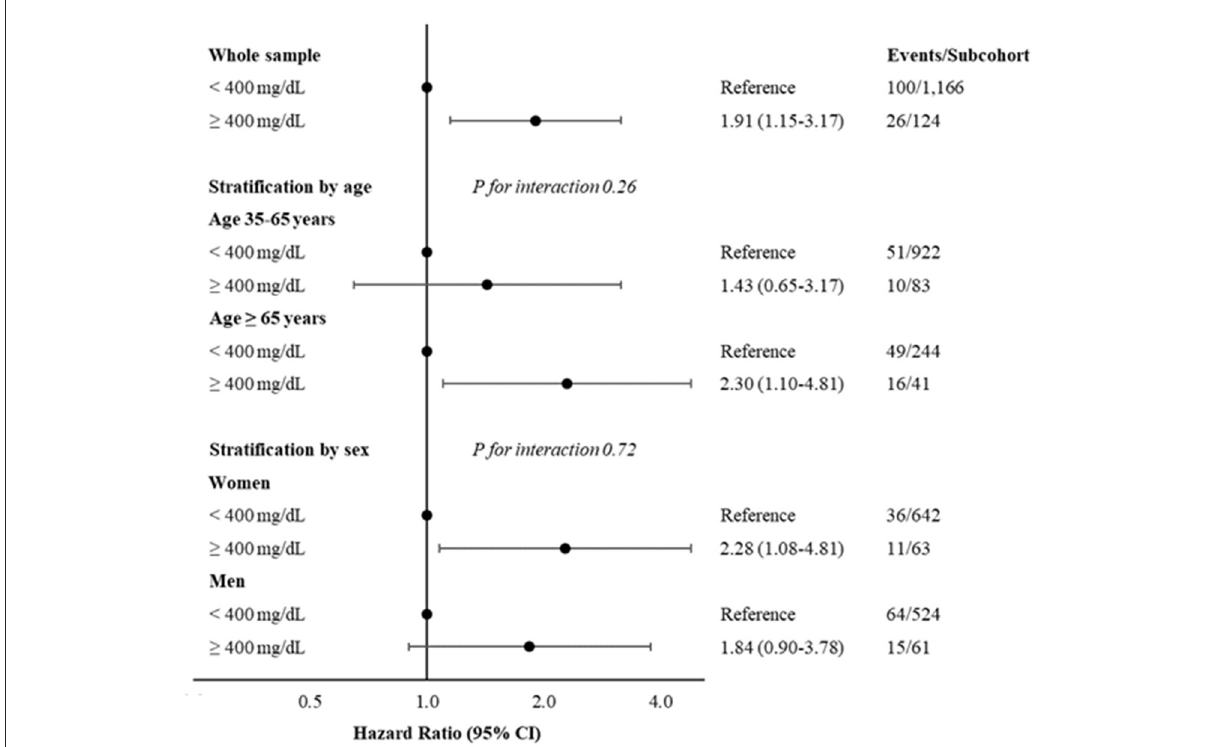
FIGURE1 Hazard ratios and 95% CI, for developing colorectal cancer according to levels of fibrinogen < or ≥ 400 mg/dL, in whole sample and stratified by age (35–65 years and ≥ 65 years) or sex. Multivariable model adjusted for age (when not stratified by), sex (when not stratified by), CRC family history, income, physical activity, diabetes medication and hypercholesterolemia. CRC, colorectal